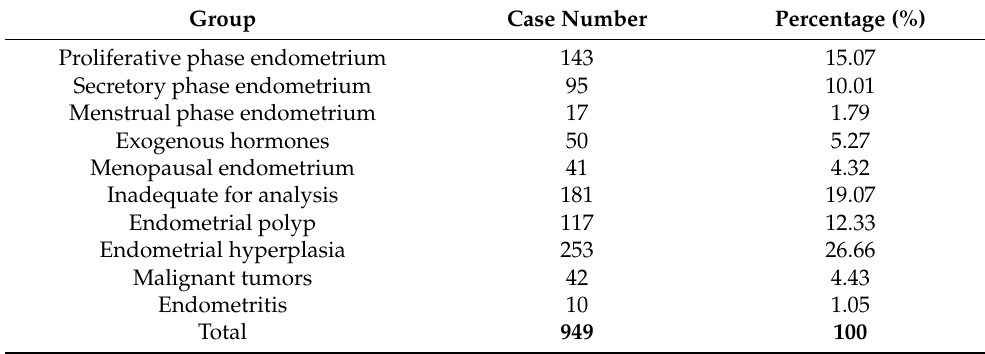
Table 5. Histopathological findings of cases where operation aimed at the extraction of endometrium.